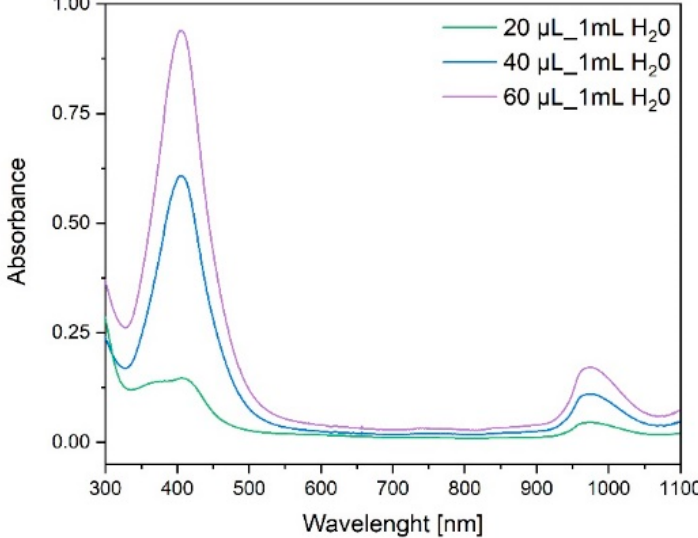
Figure 3. UV–Vis absorption spectroscopy of silver nanoparticles solutions.